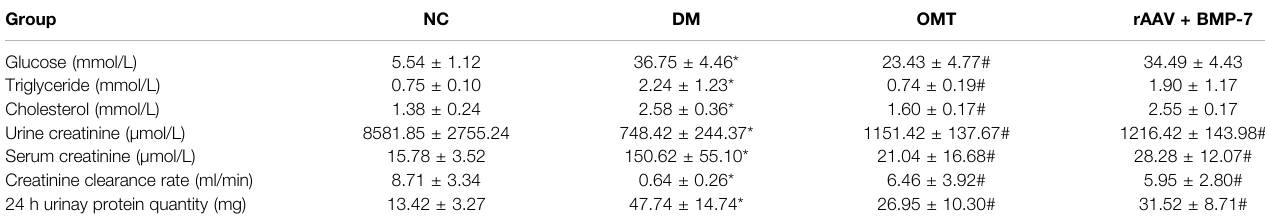
TABLE 3 | Detection of renal function and metabolism-related indicators in each group. Group